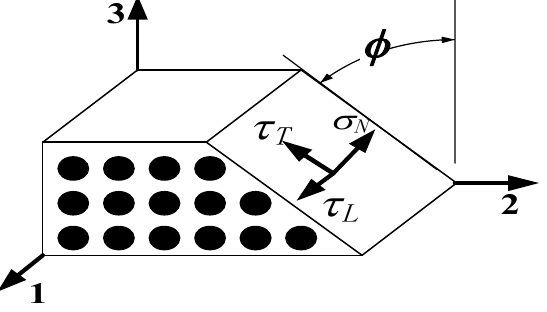
Figure 1. Traction components in the fracture plane, based on [31].